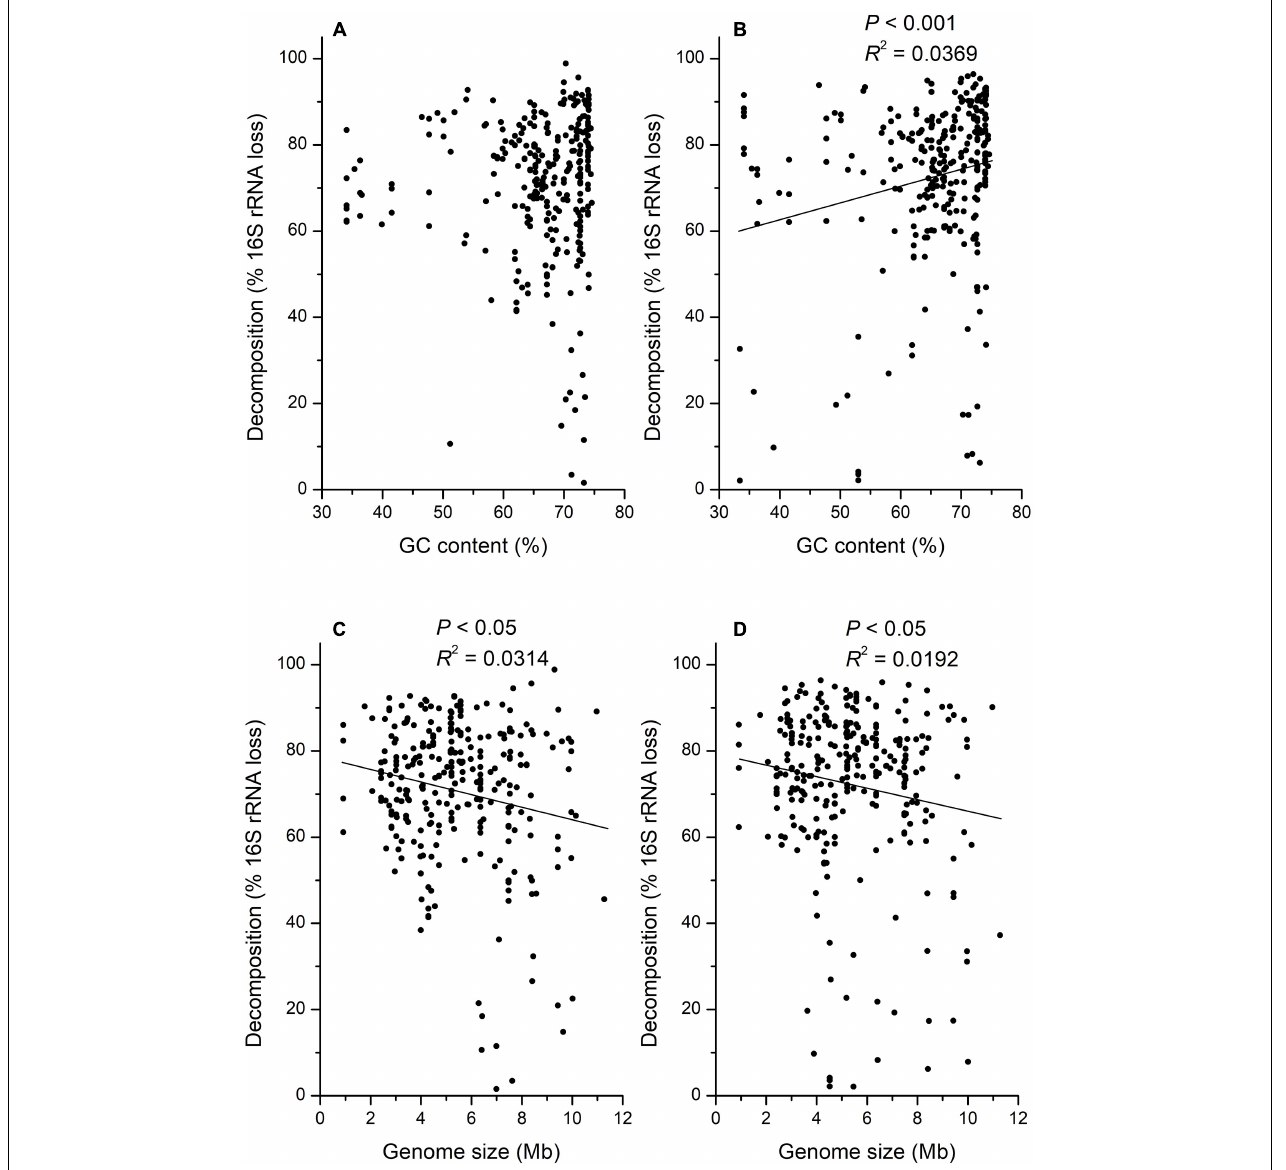
FIGURE 5 | Correlation analysis for the decomposition of 16S rRNA gene in H 218 O light fraction (dead bacteria and archaea) with GC content of DNA at 15 (A) , or 30 (B) days, and DNA genome size at 15 (C) , or 30 (D)